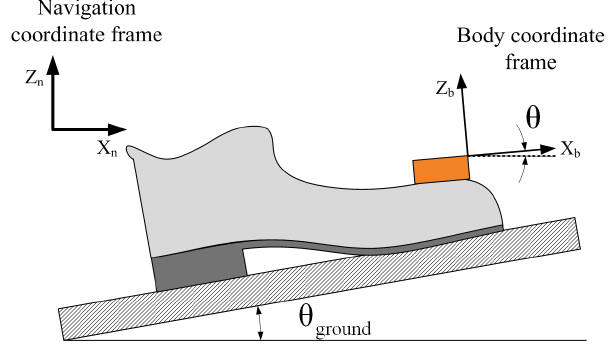
Figure 2. Roll angle θ of the sensor unit when a foot is on a